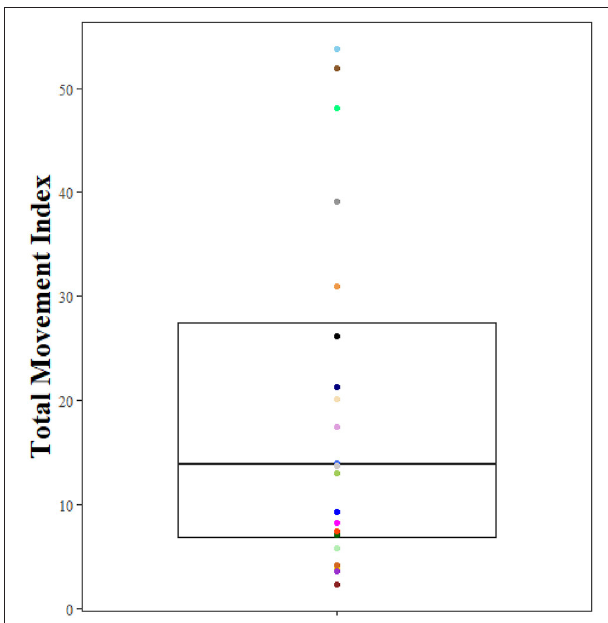
FIGURE 3 | Boxplot showing the median (line) and interquartile range (box) of the distribution of the total movement index calculated for each calf from the isolation box test. Each color represents an individual calf.